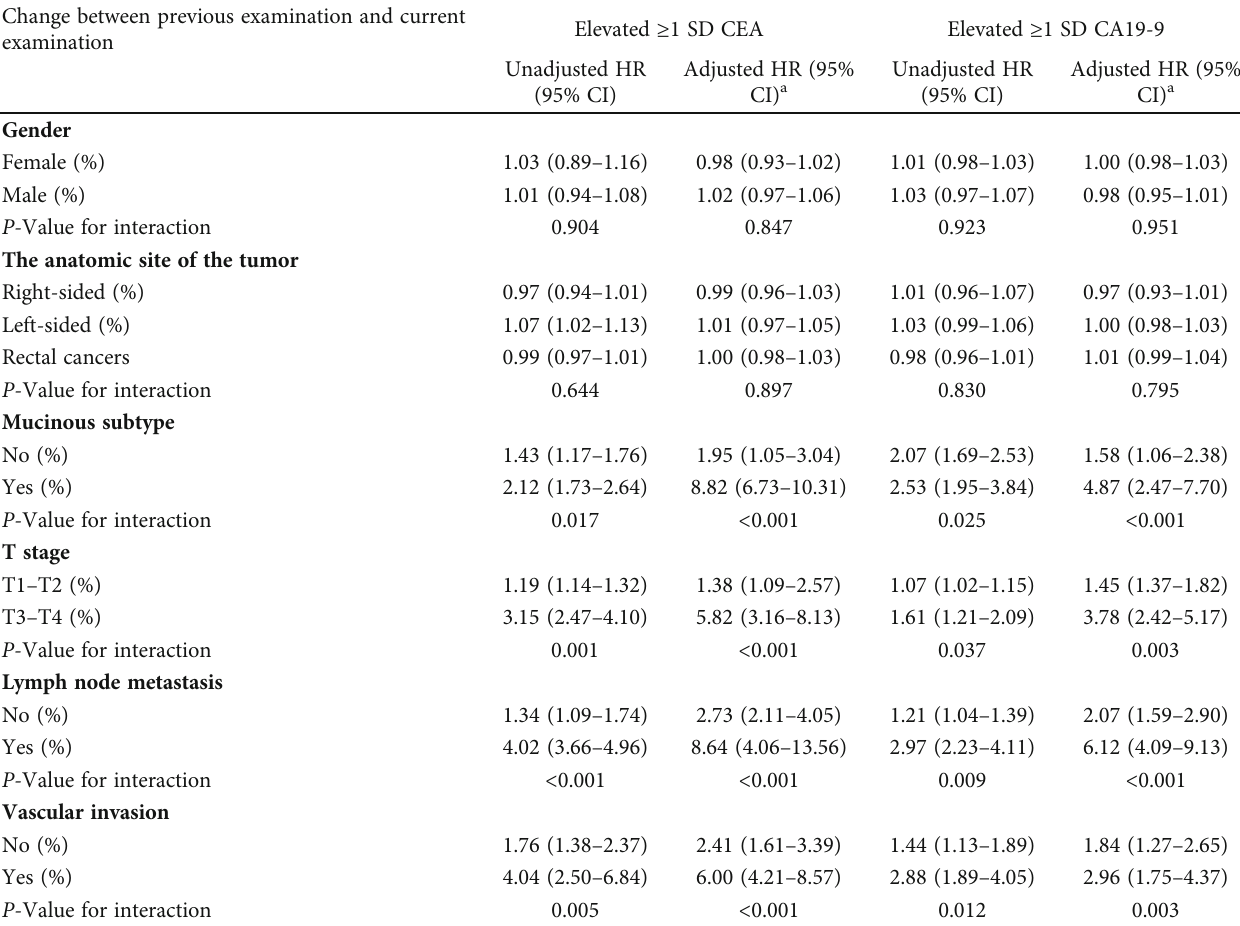
Table 3: Subgroup analysis for HR for recurrence based on changes in CEA and CA 19-9.